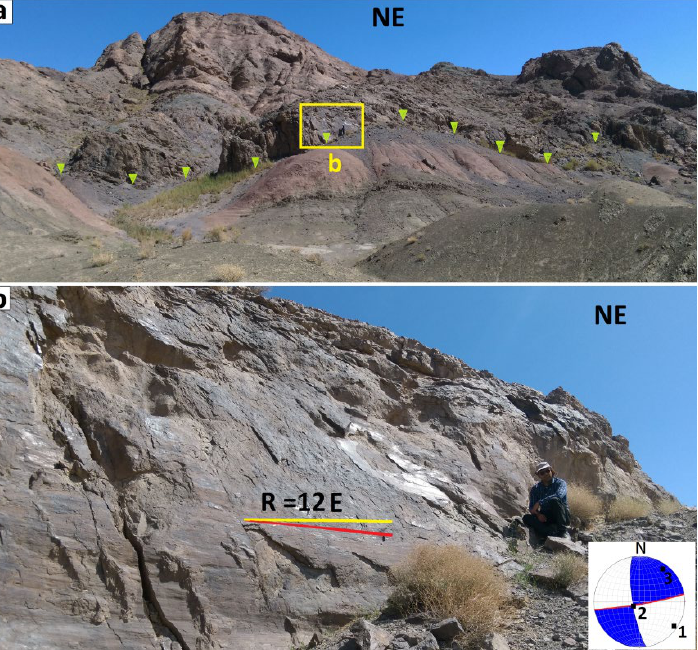
Figure 9. ( a ) Field photo of F7 fault with dextral mechanism, the trace is shown by triangles; ( b ) slicken line on the minor fault. In the stereonet, the numbers 1, 2, and 3 represent the orientation of the principal axes of stress.